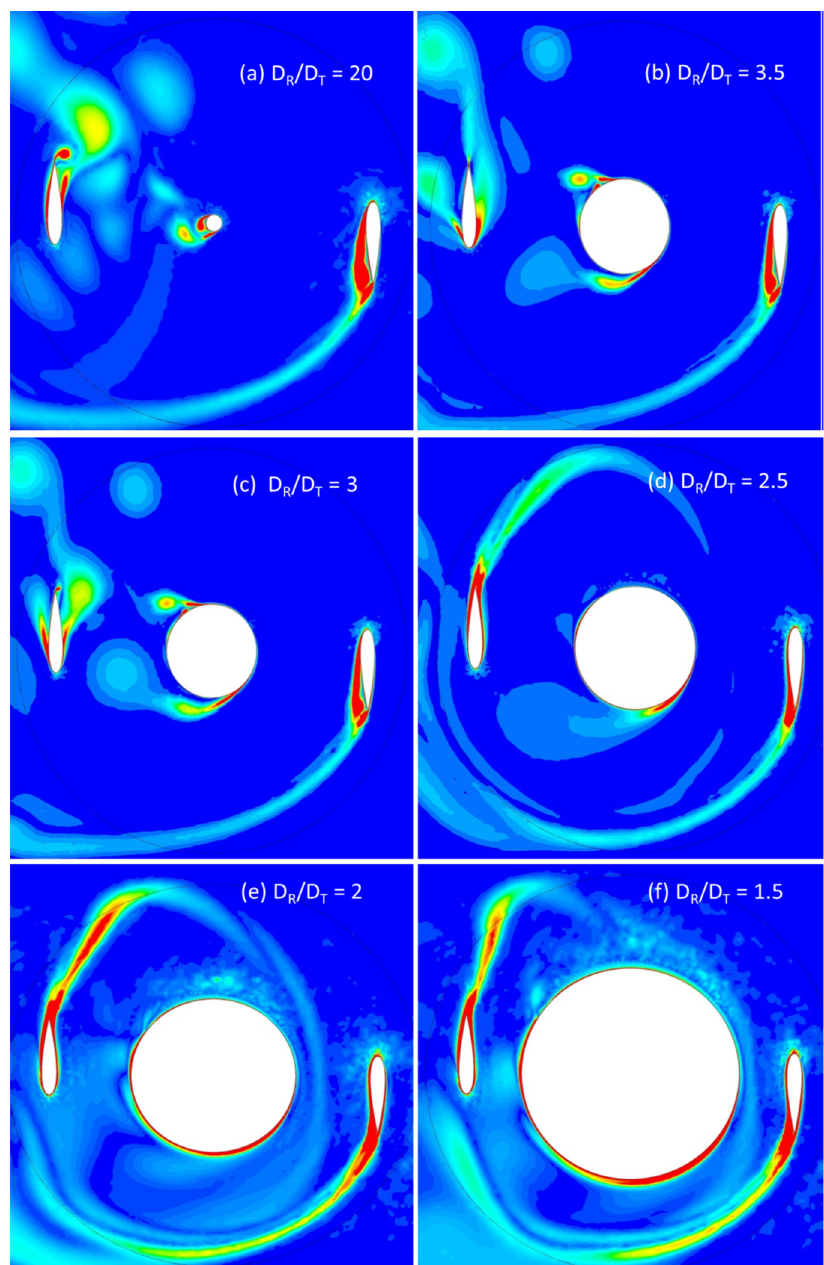
Figure 10. Vorticity contours (S −1 ) for AHDT at β = 0°.